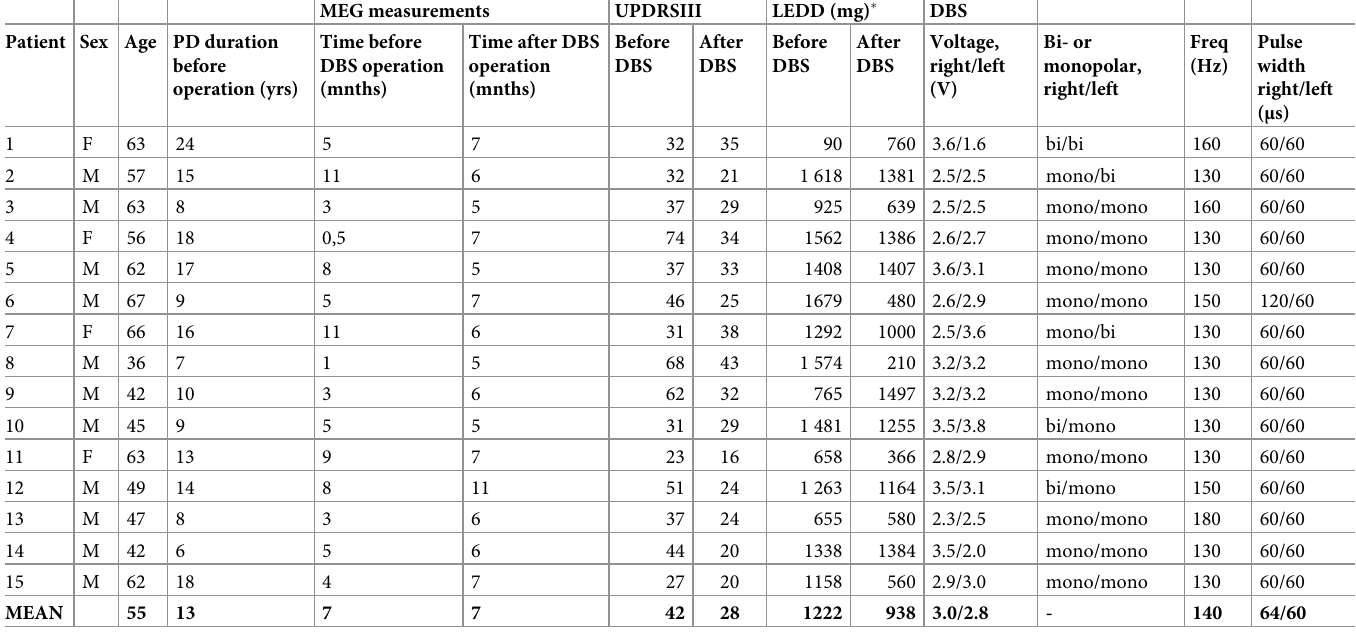
Table 1. Clinical details of patients and DBS